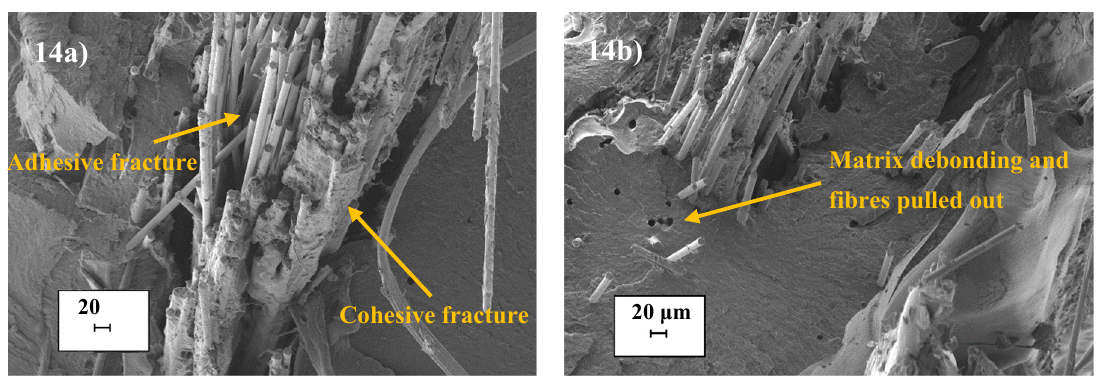
Figure 14. 3 K fibers sample after tensile tests; ( a ) matrix debonding; ( b ) carbon fibers pulled out.